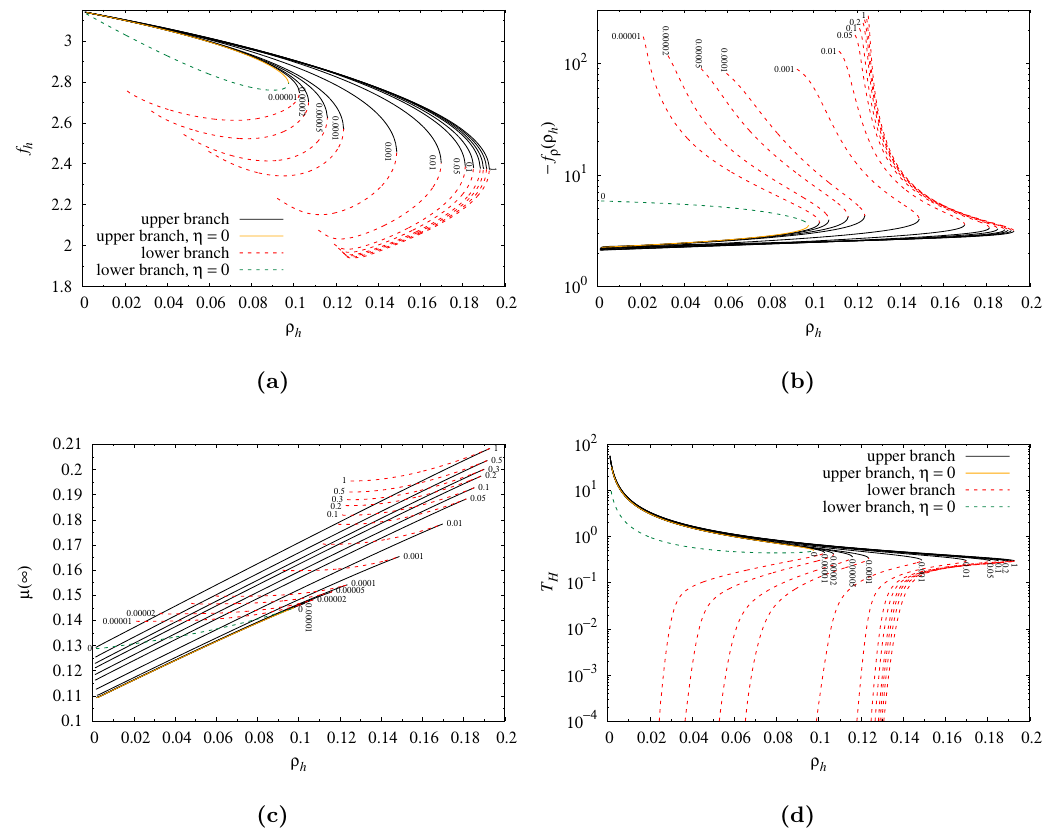
Figure 17 . Upper (black solid lines) and lower (red dashed lines) branches of solutions in the 2 + 4 + 12 model, where instead of decreasing (cid:12) , we will send (cid:17) to zero: (a) the value of the pro(cid:12)le function at the horizon, f h ; (b) the derivative of the pro(cid:12)le function at the horizon, f (cid:26) ( (cid:26) h ); (c) the ADM mass, (cid:22) ( 1 ); (d) the Hawking temperature T H , all as functions of the size of the black hole, i.e. the horizon radius, (cid:26) h . The numbers on the (cid:12)gures indicate the di(cid:11)erent values of (cid:17) = 0, 10 (cid:0) 5 , 2 (cid:2) 10 (cid:0) 5 , 5 (cid:2) 10 (cid:0) 5 , 10 (cid:0) 4 , 0 : 001, 0 : 01, 0 : 05, 0 : 1, 0 : 2, 0 : 3, 0 : 5, 1. The upper and lower (cid:17) = 0 branches are shown in orange and dark green colors,